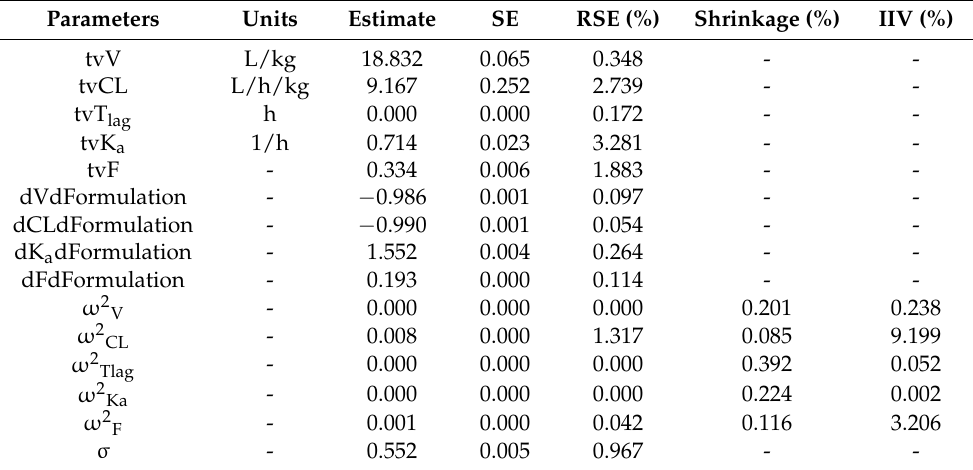
Table 9. Estimated population pharmacokinetic parameters for methotrexate-loaded nanoformula- tions in the final